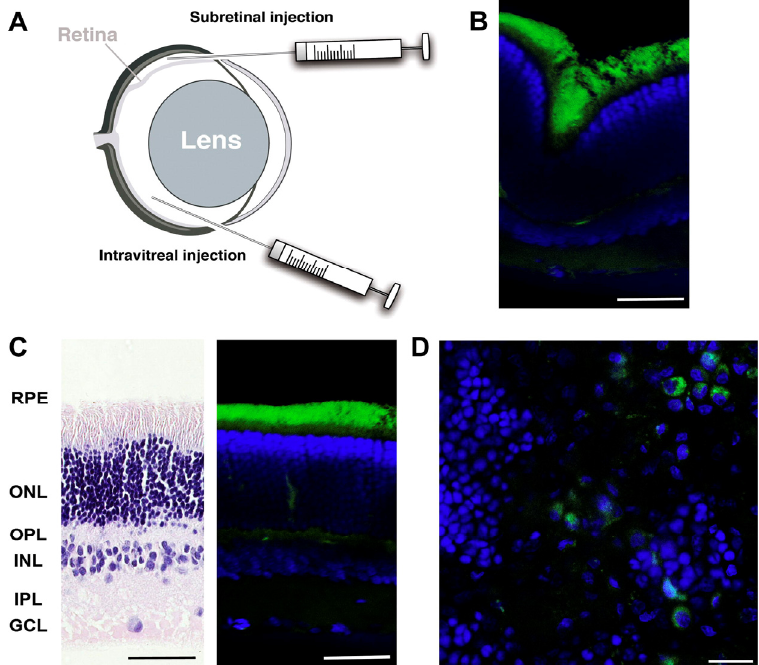
Figure 9. In vivo gene expression of GFP after administration of oligochitosan/DNA polyplexes at N/P ratio 10 to rats. ( A ) Schematic drawing of the subretinal and intravitreal injection. ( B ) Cross-section of a treated retina close to the place of the subretinal injection. Enhanced green fluorescent protein (EGFP) expression with Hoechst 33342 staining for cell nuclei. Scae bar = 50 µm. ( C ) Hematoxylin-eosin rat retina cross-section, showing the different layers of the retina. RPE (Retinal Pigment Epithelium layer), ONL (Outer nuclear layer), OPL (Outer plexiform layer), INL (Inner nuclear layer), GCL (Ganglion cell layer) and fluorescent microscopy image of a 5-µm treated retina cross-section. Scale bar = 50 µm. ( D ) Whole-mount views of several sections of the retina focused at the RPE layer. Scale bar = 100 µm. Reproduce from [33] with permission from